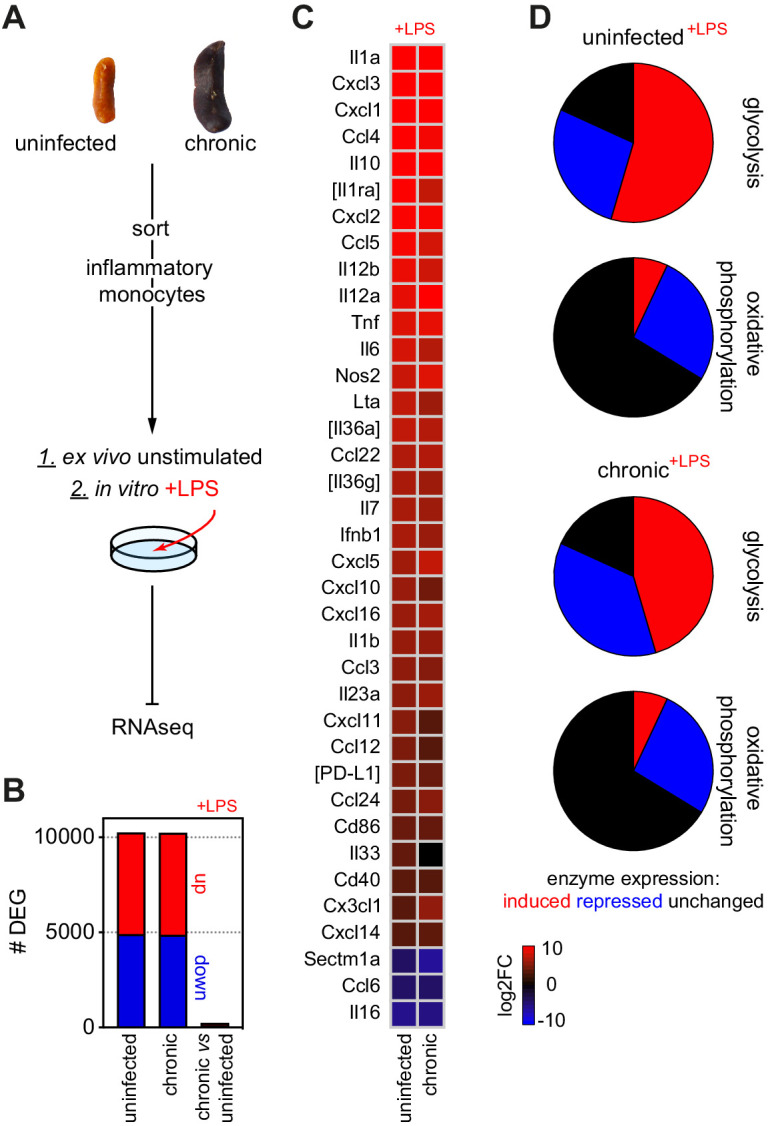
Quiescent monocytes can differentiate into inflammatory macrophages when removed from the spleen.(A) Spleen monocytes were flow-sorted from uninfected mice (n = 4) or mice chronically infected with P. chabaudi AJ (40 days p.i., n = 5). Sorted cells were then prepared immediately for RNA sequencing (ex vivo) or stimulated in vitro with LPS for 4 hr before RNA sequencing. (B) The number of differentially expressed genes (DEG, padj <0.01, >1.5-fold change) between LPS-stimulated and unstimulated (ex vivo) monocytes is shown for uninfected mice (left bar) and chronically infected mice (centre bar). Note that a direct comparison between LPS-stimulated monocytes from chronically infected mice and uninfected controls yielded only 229 DEG (right bar). (C) Log2 fold change (FC) of inflammatory markers showing the differentiation of monocytes in vitro after LPS stimulation (data shown relative to ex vivo samples). Square brackets indicate that common gene names were used. (D) Transcriptional regulation of glycolysis and oxidative phosphorylation after LPS stimulation (relative to ex vivo samples). Data include the major glucose transporters and glycolytic enzymes, and all enzymatic subunits that form complex I to IV in the electron transport chain and ATP synthase.